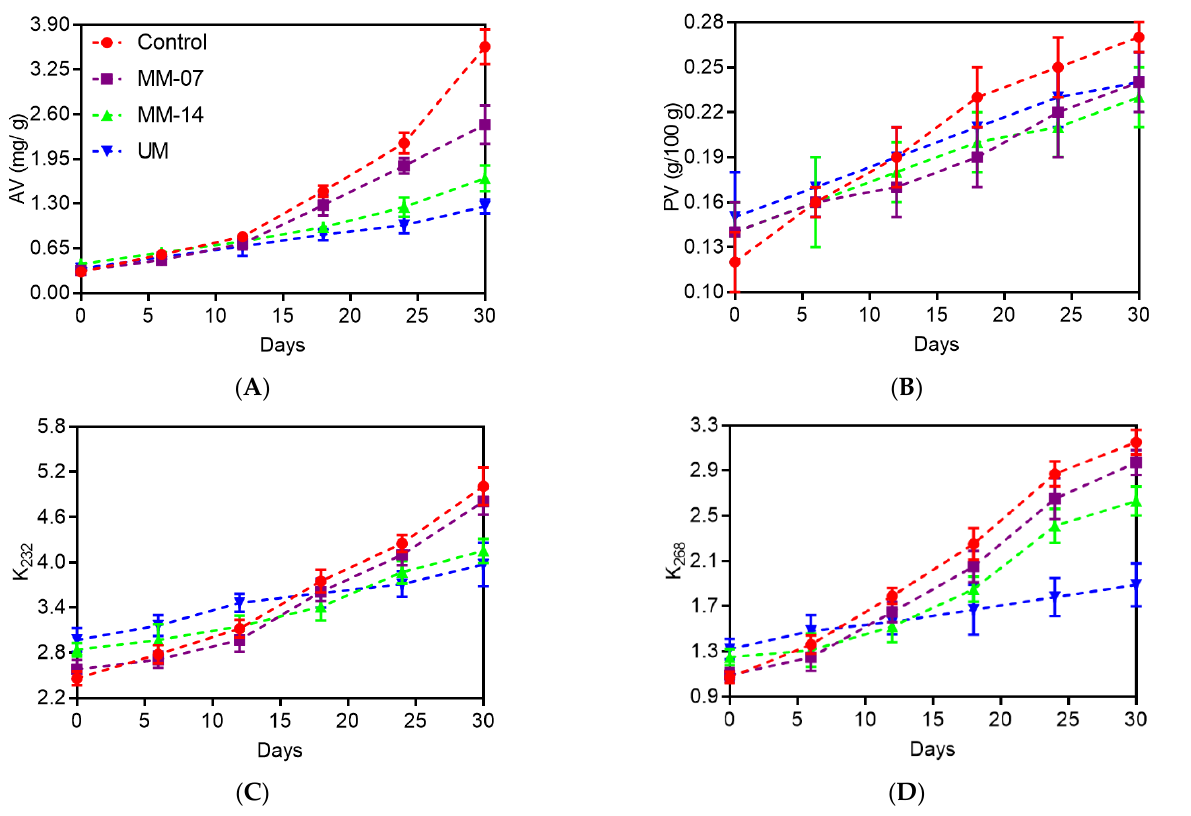
Figure 1. The variation in the levels of AV ( A ), PV ( B ), K 232 ( C ) and K 268 ( D ) in the accelerated storage at 65 ° C for 30 days. Control: SFO sample produced by the cold-pressing method; MM-07: SFO sample produced by a maceration procedure for 7 days; MM-14: SFO sample produced by a maceration procedure for 14 days; UM: SFO sample produced by an ultrasound-assisted maceration for 10 min.